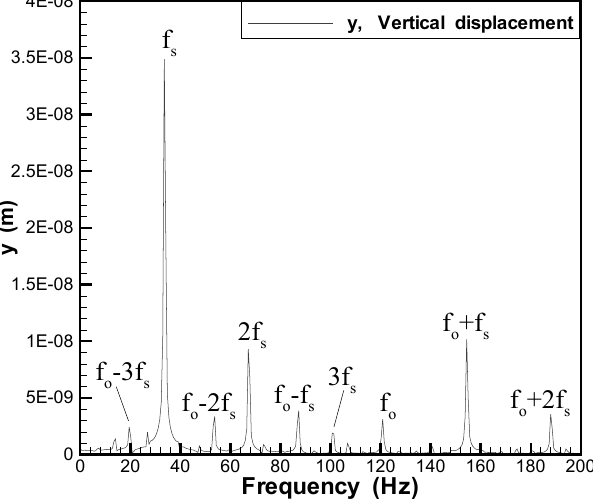
Fig. 7. FFT of the mass center ( C.G ) vertical displacement of deep groove ball bearing (DGBB) SKF6002. respectively. FFT is marked with vibration tones at f o , f s and its higher harmonics in addition to peaks at ( f o ± nf s ) and this agrees with the analytical and experimental results of Ref.